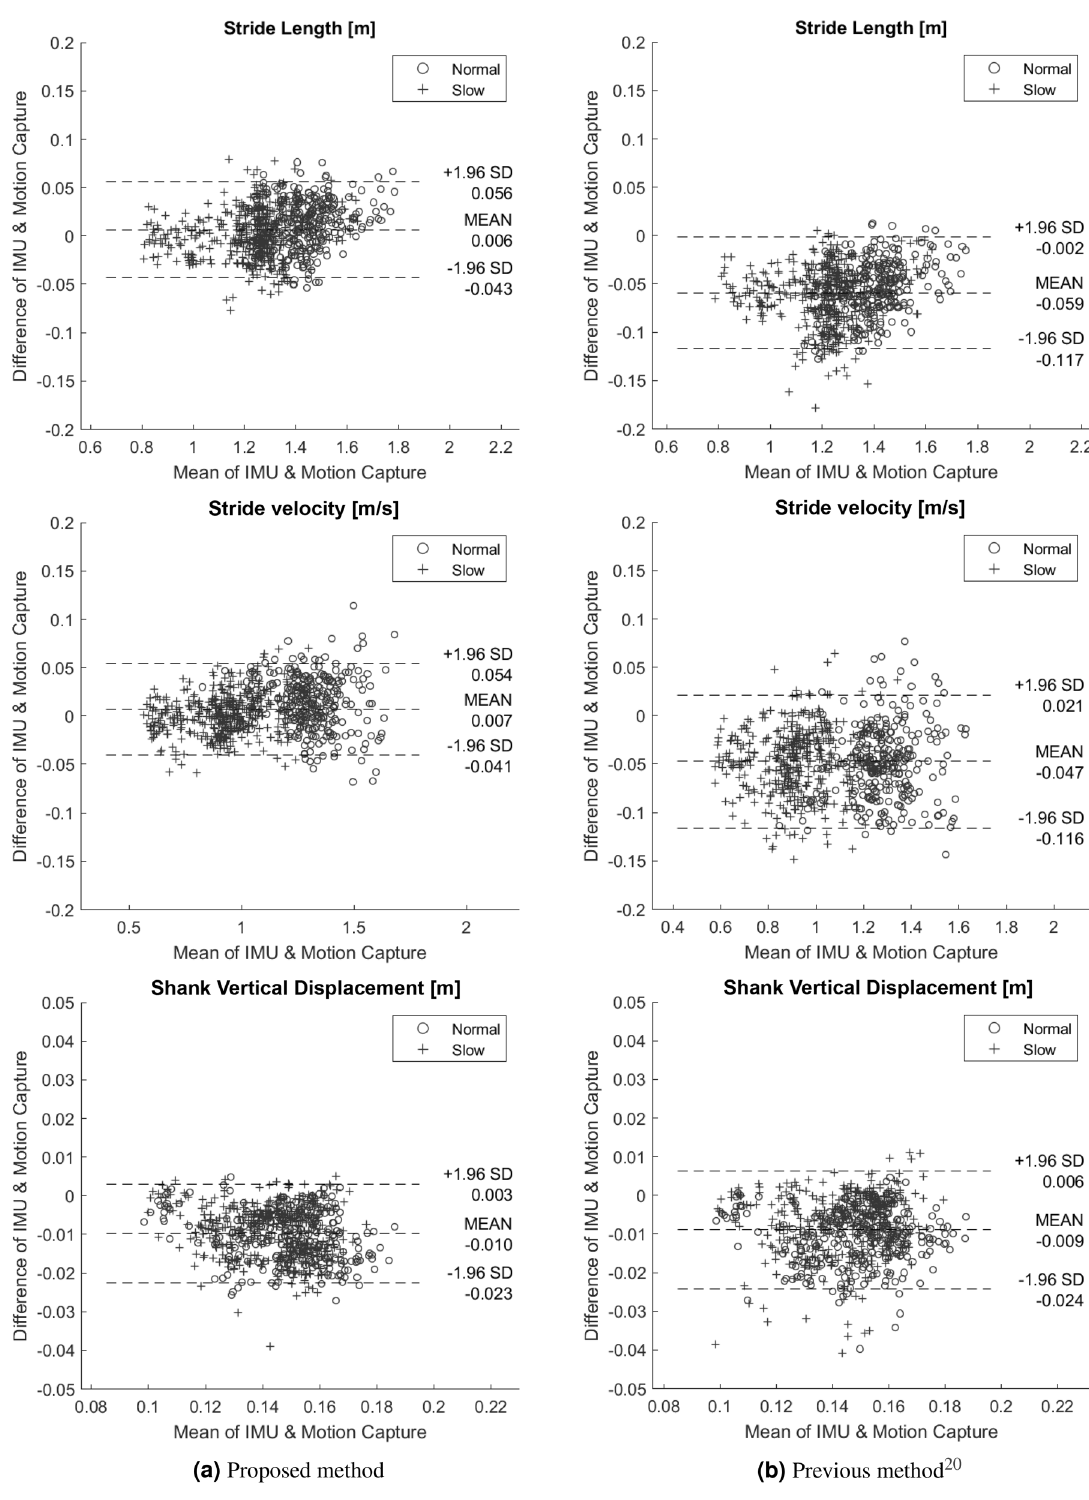
Figure 2. Bland–Altman plot for stride length, stride velocity, and shank vertical displacement estimated by ( a ) the proposed method and ( b ) the previous method 20 for 283 strides under the normal speed task ( ◦ ) and 412 strides under the slower speed task (+). The Bland–Altman plot provides information about the mean difference, which indicates the bias between two systems, and the 95% confidence interval, which is known as the limit of agreement (LOA) that shows the difference between the values measured by two systems for most individuals 27